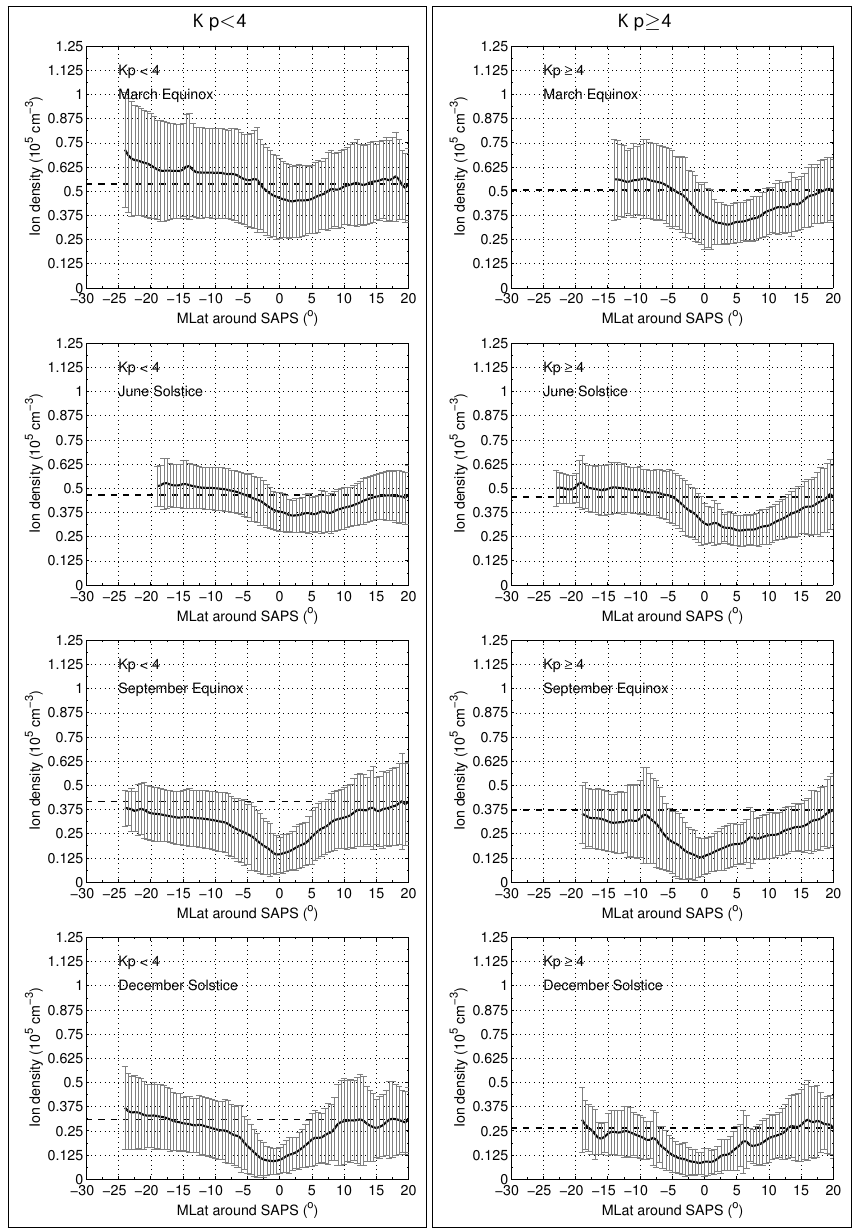
Fig. 4. The same as Figure 2, but for electron density. The background level is indicated by a dashed line.